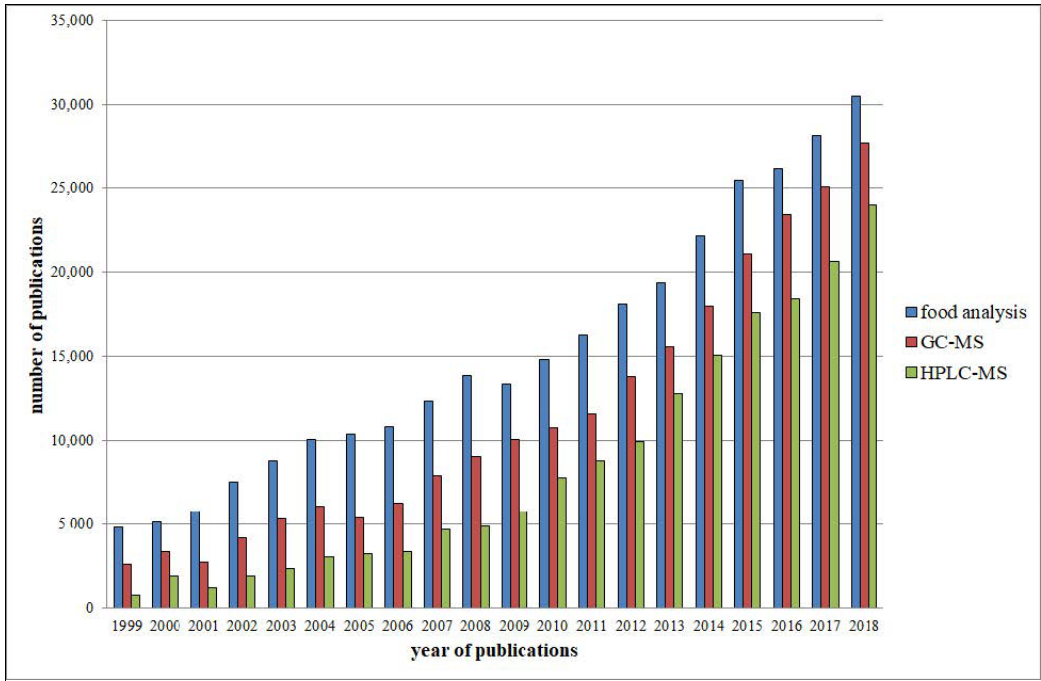
Figure 1. Evaluation of the manuscripts linked to food analysis, and those using GC–MS (20-fold) or HPLC–MS methods (50-fold). The x -axis represents the year of publications, while the y -axis represents the number of publications. Data derived from the Scopus database using the search term “food analysis” coupled (using “AND” as relationship term) with “HPLC–MS” and “GC–MS”, respectively. HPLC–MS = high performance liquid chromatography–mass spectrometry; GC–MS = gas chromatography–mass spectrometry.